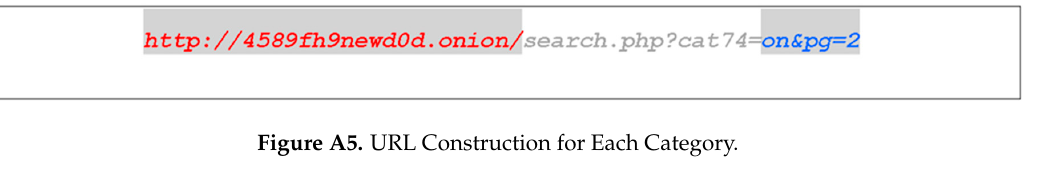
Figure A5. URL Construction for Each Category.